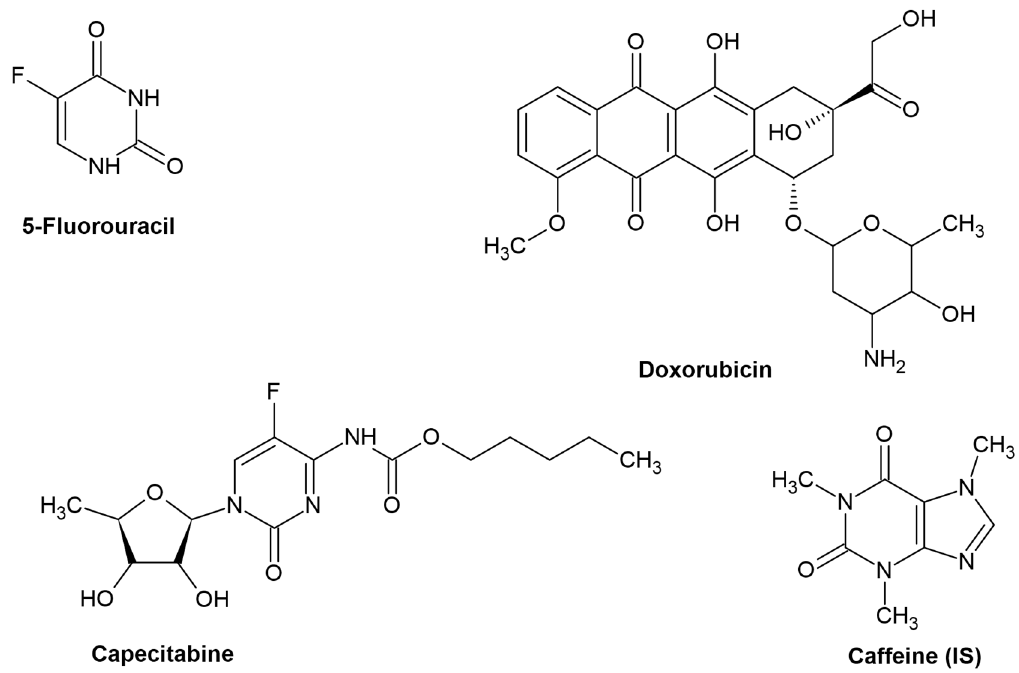
Figure 1. Chemical structure of the studied compounds and the utilized IS.